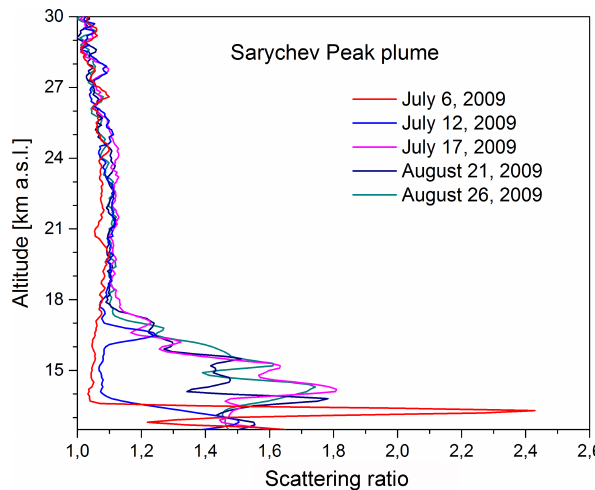
Figure 8. Detection of the Sarychev Peak volcanic plumes in the stratosphere over Tomsk. The volcano erupted in the Kuril Islands from 11 to 16 June 2009.